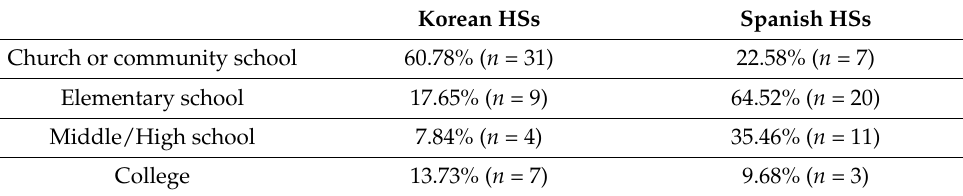
Table 1. First formal heritage language (HL) instruction settings among Korean and Spanish HSs.